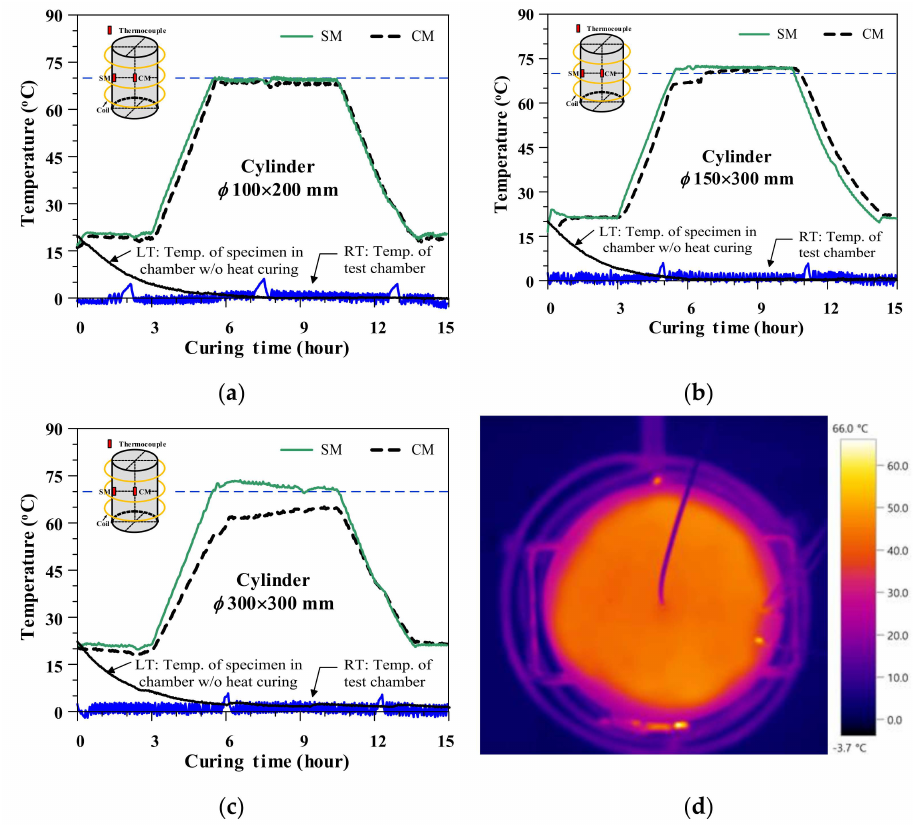
Figure 9. Temperature distributions of the concrete measured during induction heat curing: ( a ) cylin- der with dimensions φ 100 × 200 mm; ( b ) cylinder with dimensions φ 150 × 300 mm; ( c ) cylinder with dimensions φ 300 × 300 mm; ( d ) infrared thermal camera image of the cylinder with φ 150